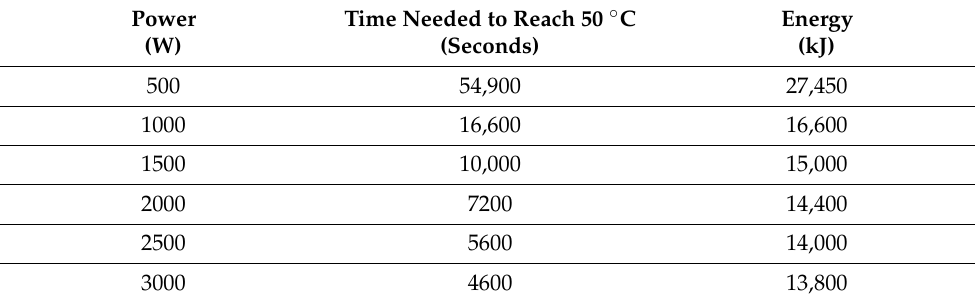
Table 2. Parameters of the